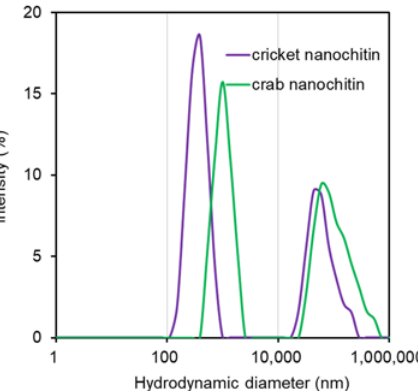
Figure 6. Hydrodynamic diameter of nanochitin from cricket and crab shell.